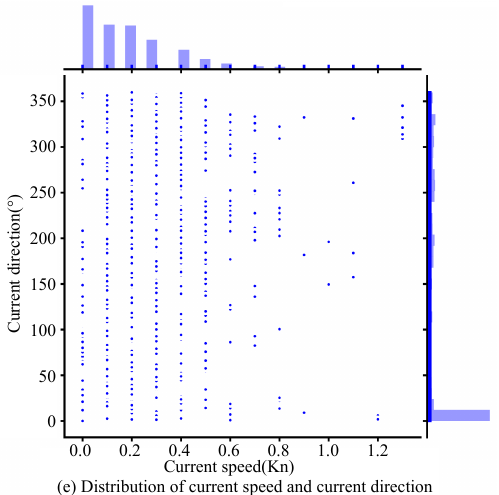
Figure 2. Data distribution of the dataset features: ( a ) Distribution of GPS speed and fuel con- sumption. ( b ) Distribution of mean draft and trim. ( c ) Distribution of wind speed and direction. ( d ) Distribution of wave height and direction. ( e ) Distribution of current speed and direction.